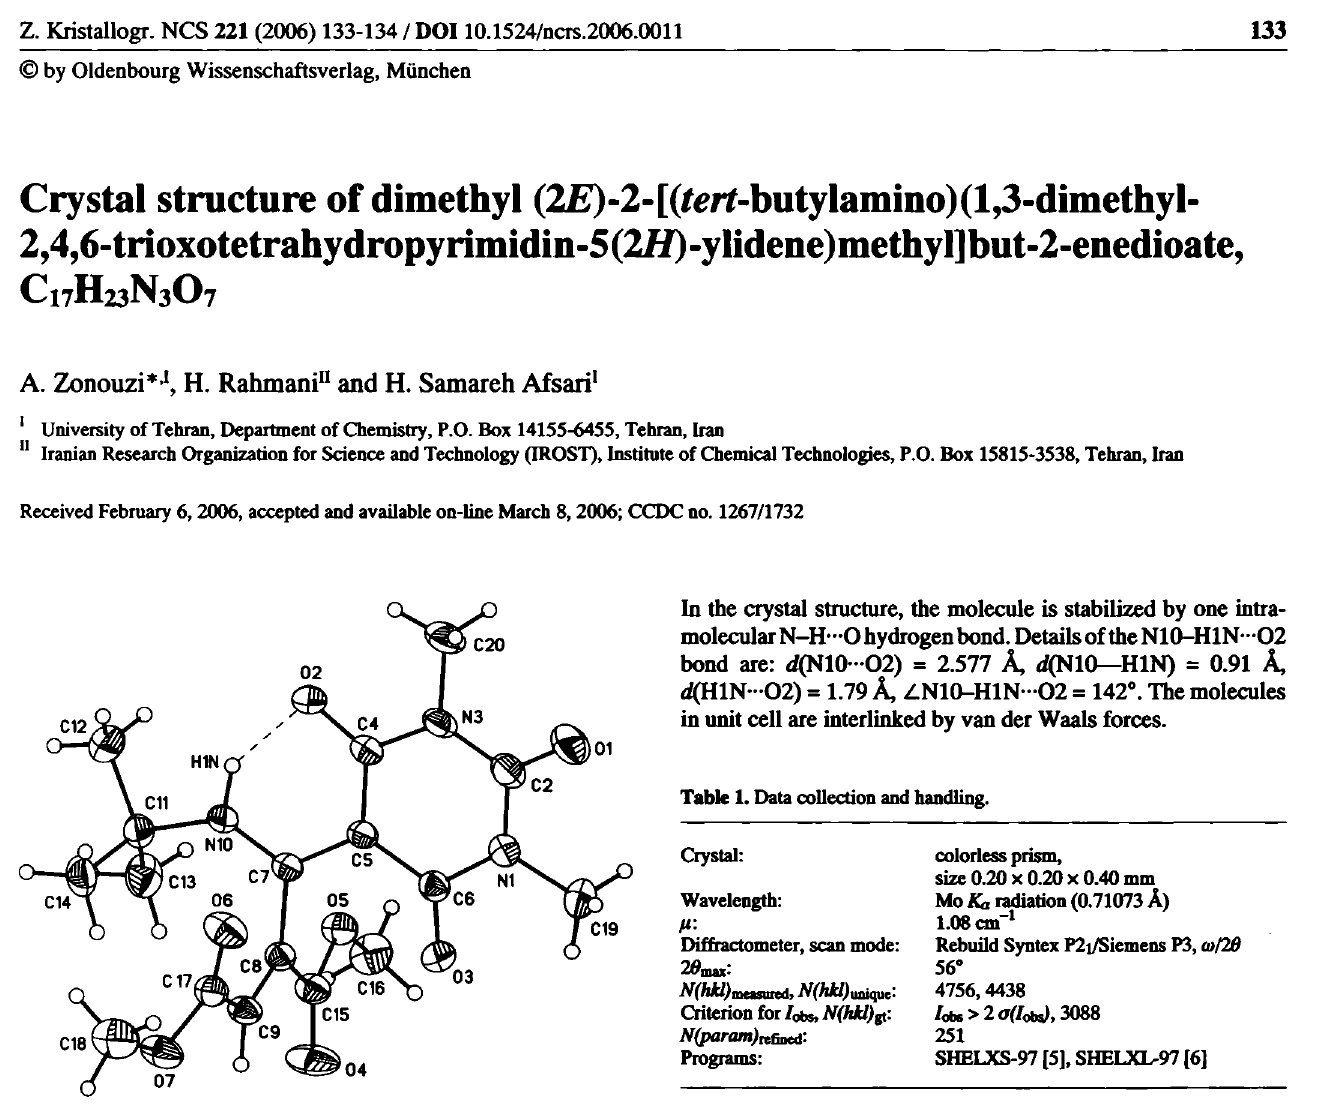
Table 2. Atomic coordinates and displacement parameters (in A 2